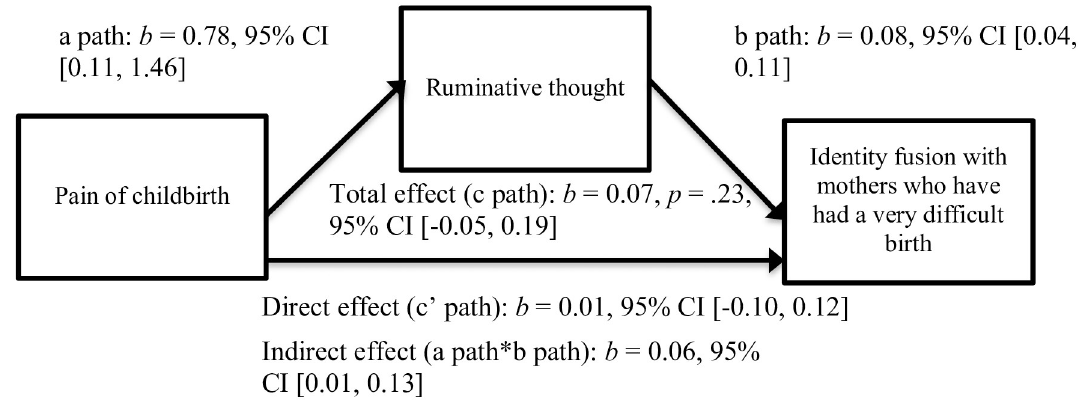
Fig 3. Mediation model of fusion with mothers who had a difficult birth via pain levels and ruminative thought.